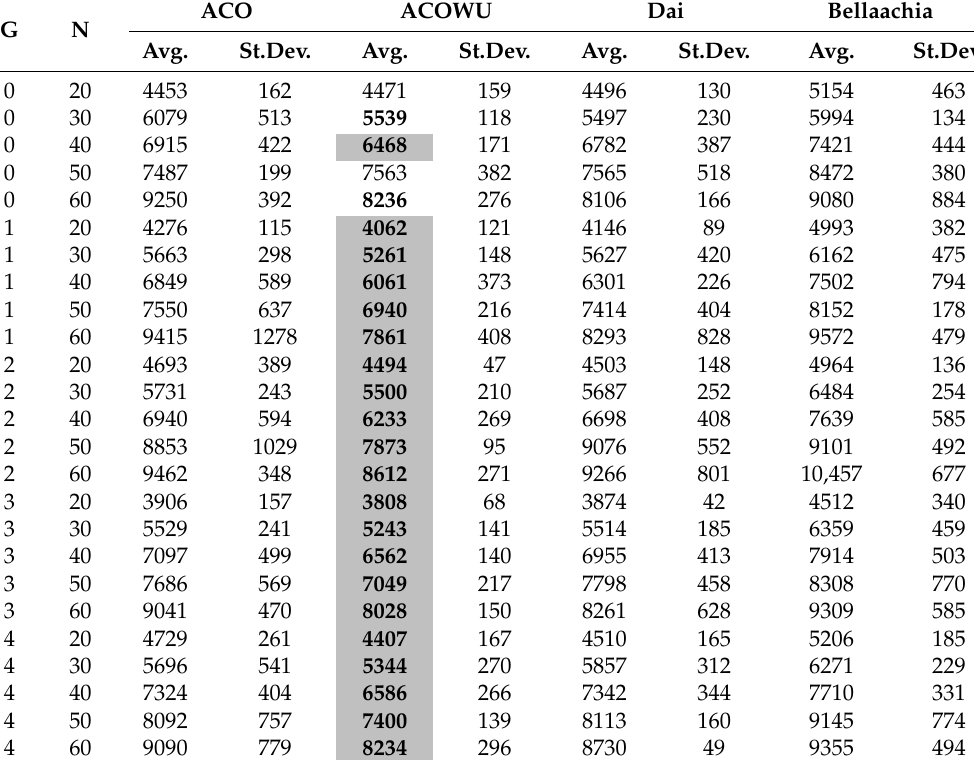
Table 2. Results obtained on generic TSP instances in terms of cost. ACO ACOWU